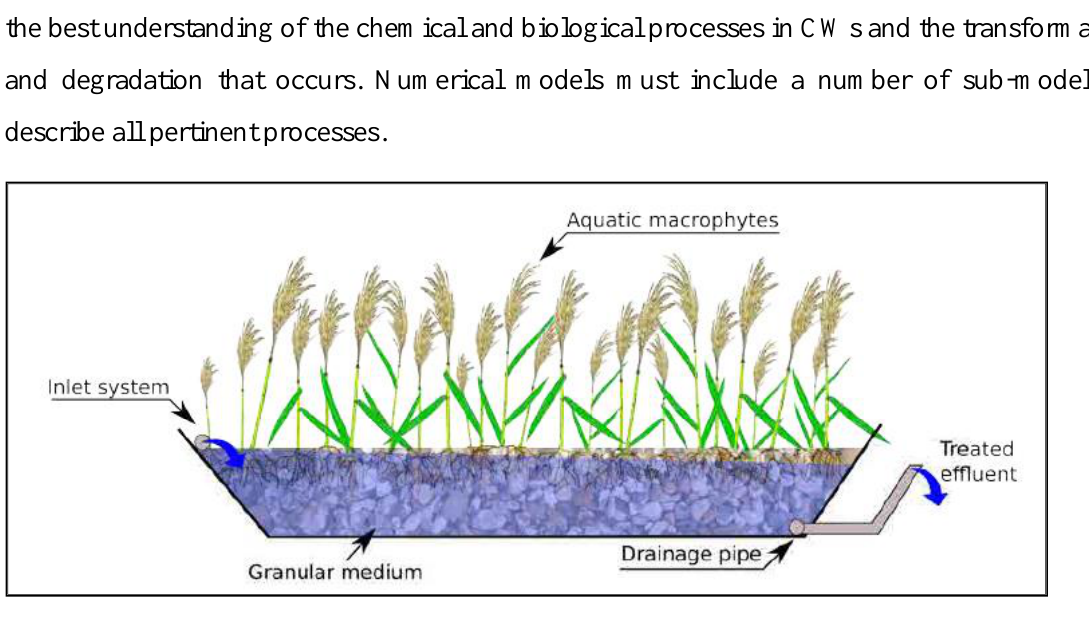
Fig. 1 Schematic Representation of an HSSF. (Roger,